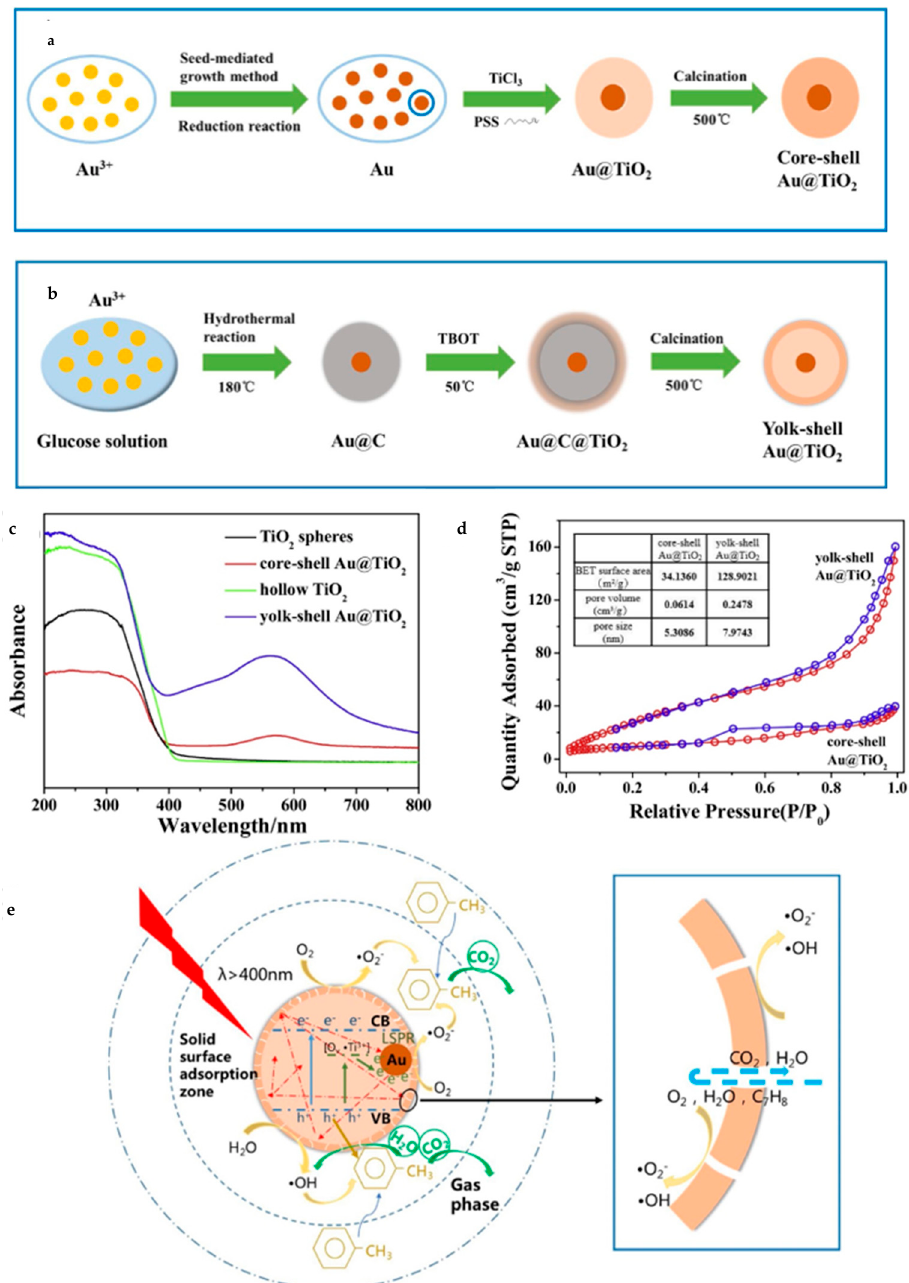
Figure 18. Schematic diagram of synthesis of ( a ) core–shell, ( b ) yolk–shell Au@TiO 2 . ( c ) UV–vis absorbance spectra for different kinds of TiO 2 spheres. ( d ) The BET curves of yolk–shell and core–shell Au@TiO 2 respectively. ( e ) The possible photocatalysis principle of Au@TiO 2 -YS. Reproduced with permission from [104]. Copyright Elsevier, 2019.